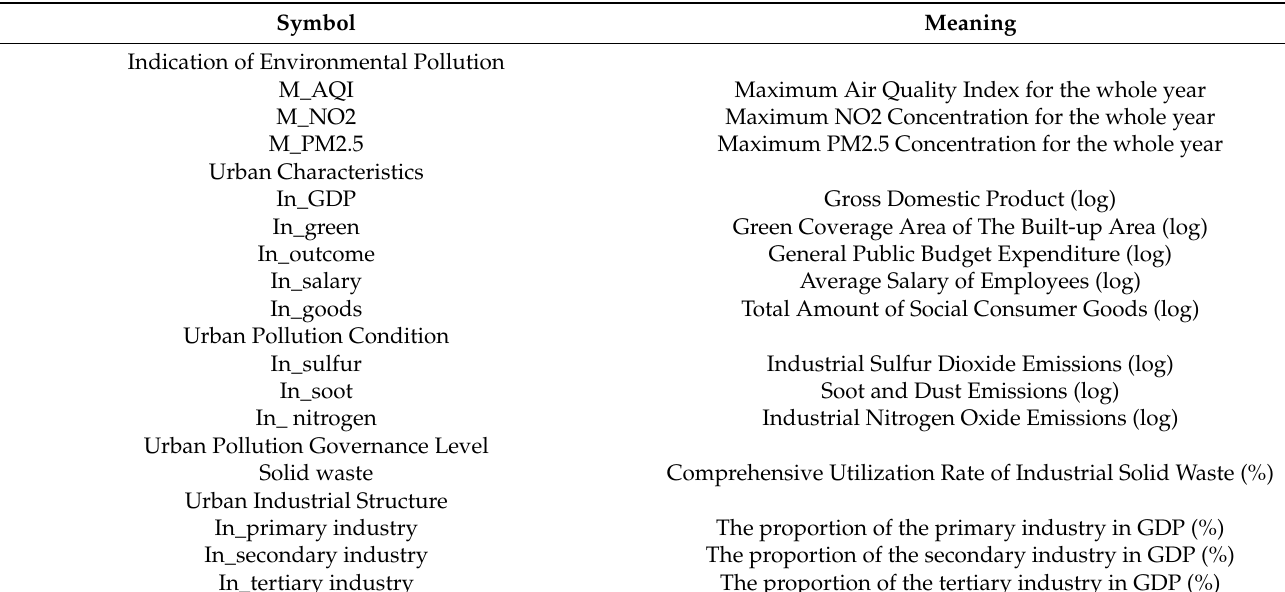
Table 1. Variables